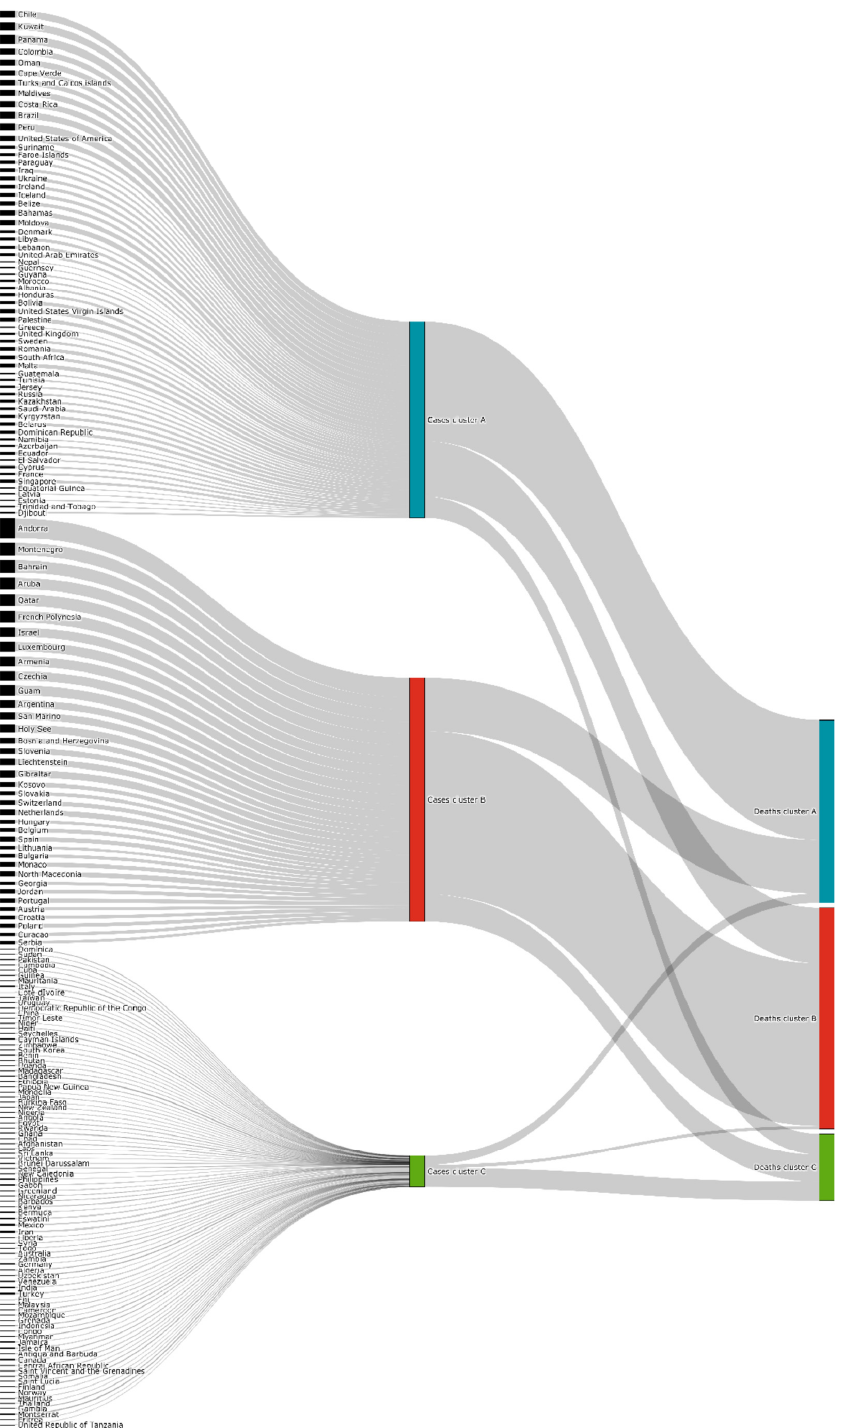
Figure 13. Cases vs. deaths: Sankey diagram with mapping of countries from case time profile clusters and from death time profile clusters (values normalized to 100,000 of the population).